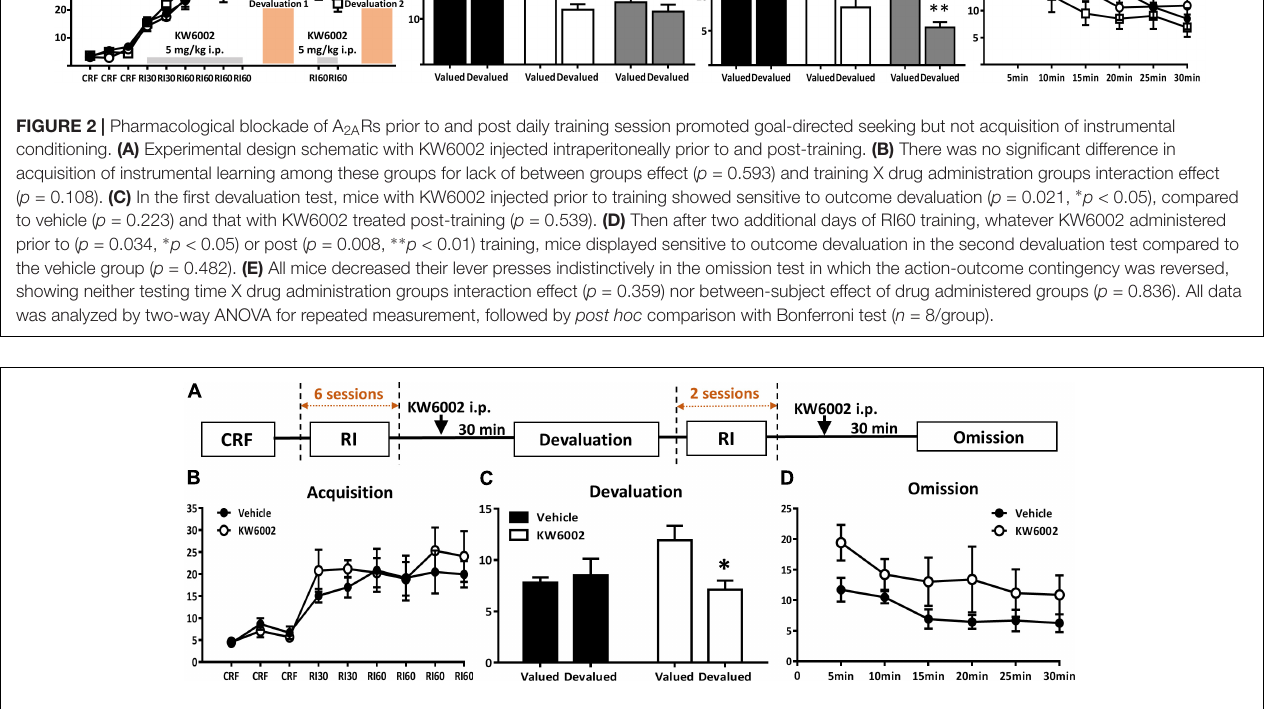
Frontiers in Pharmacology |